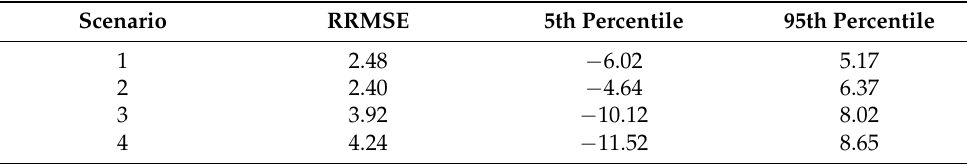
Table 1. Summary of Water Level Prediction Errors and Prediction Ranges